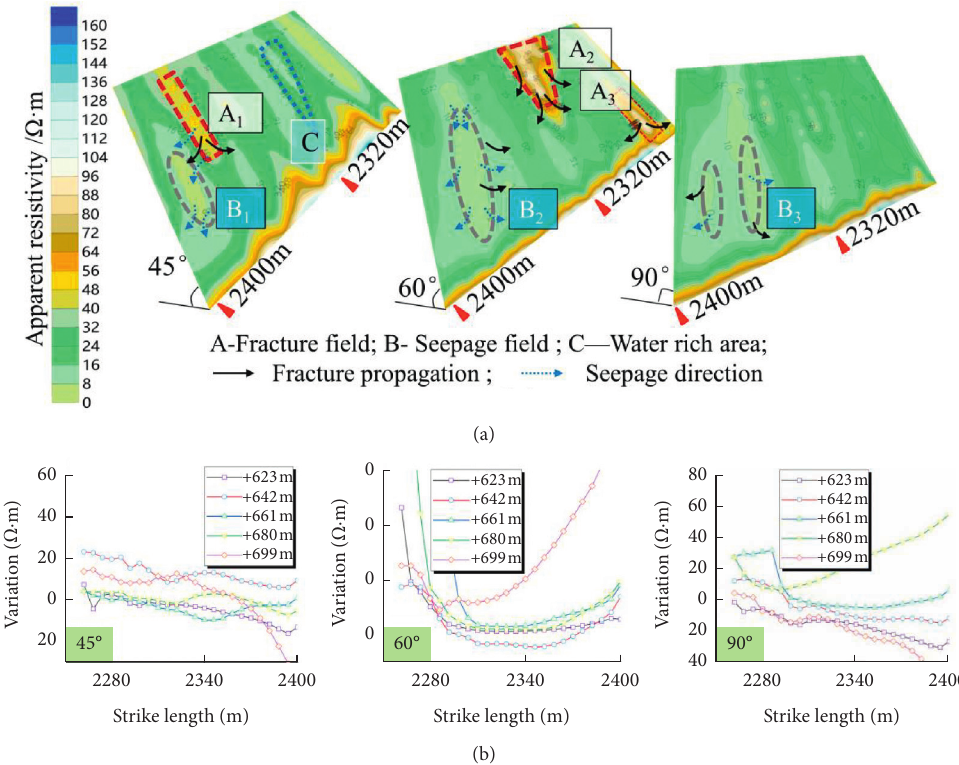
Figure 12: Visualization of effect after high stress roof cracking: (a) multifield spatial evolution diagram; (b) variation diagram of apparent resistivity of survey line.